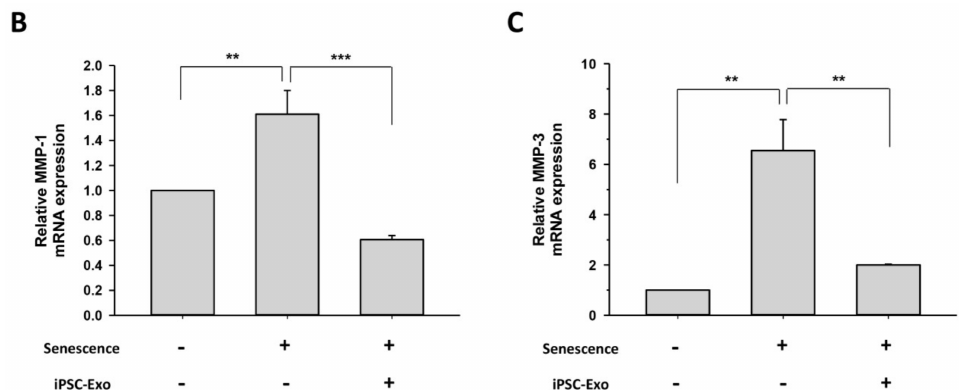
Figure 7. iPSC-Exo restored the altered expression of specific dermal markers in senescent HDFs. After treatment with 20 × 10 8 particles/mL iPSC-Exo for 24 h in serum-free DMEM/F12, HDFs were harvested after 48 h. The mRNA expression levels of collagen type I ( A ); MMP-1 ( B ); and MMP-3 ( C ) were quantified by quantitative real-time RT-PCR. ** p < 0.01, *** p < 0.001. Error bars indicate standard deviations of triplicate samples in a single representative